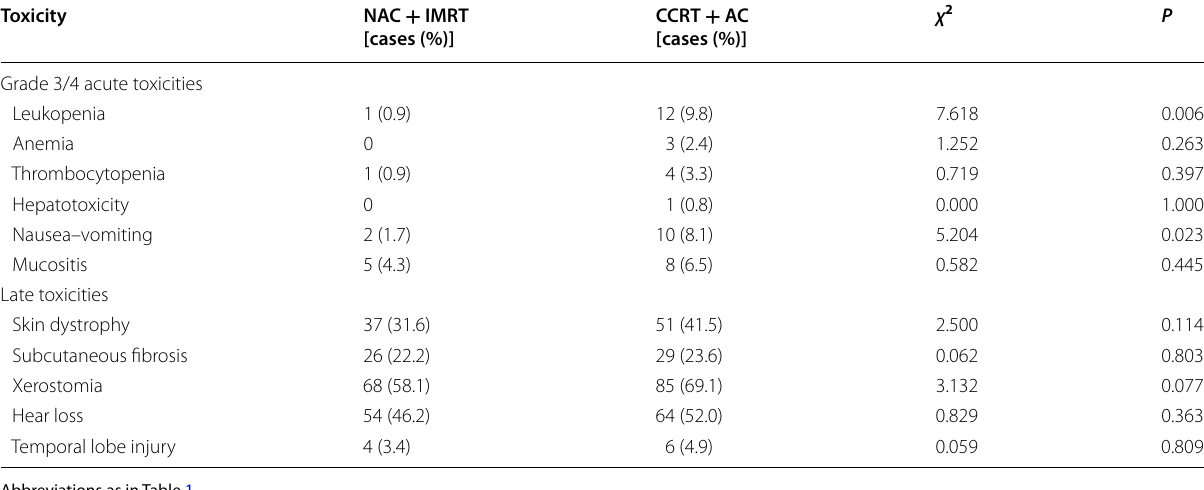
Table 3 Treatment-related toxicities in patients with locoregionally advanced NPC treated with NAC plus IMRT vs. CCRT plus AC